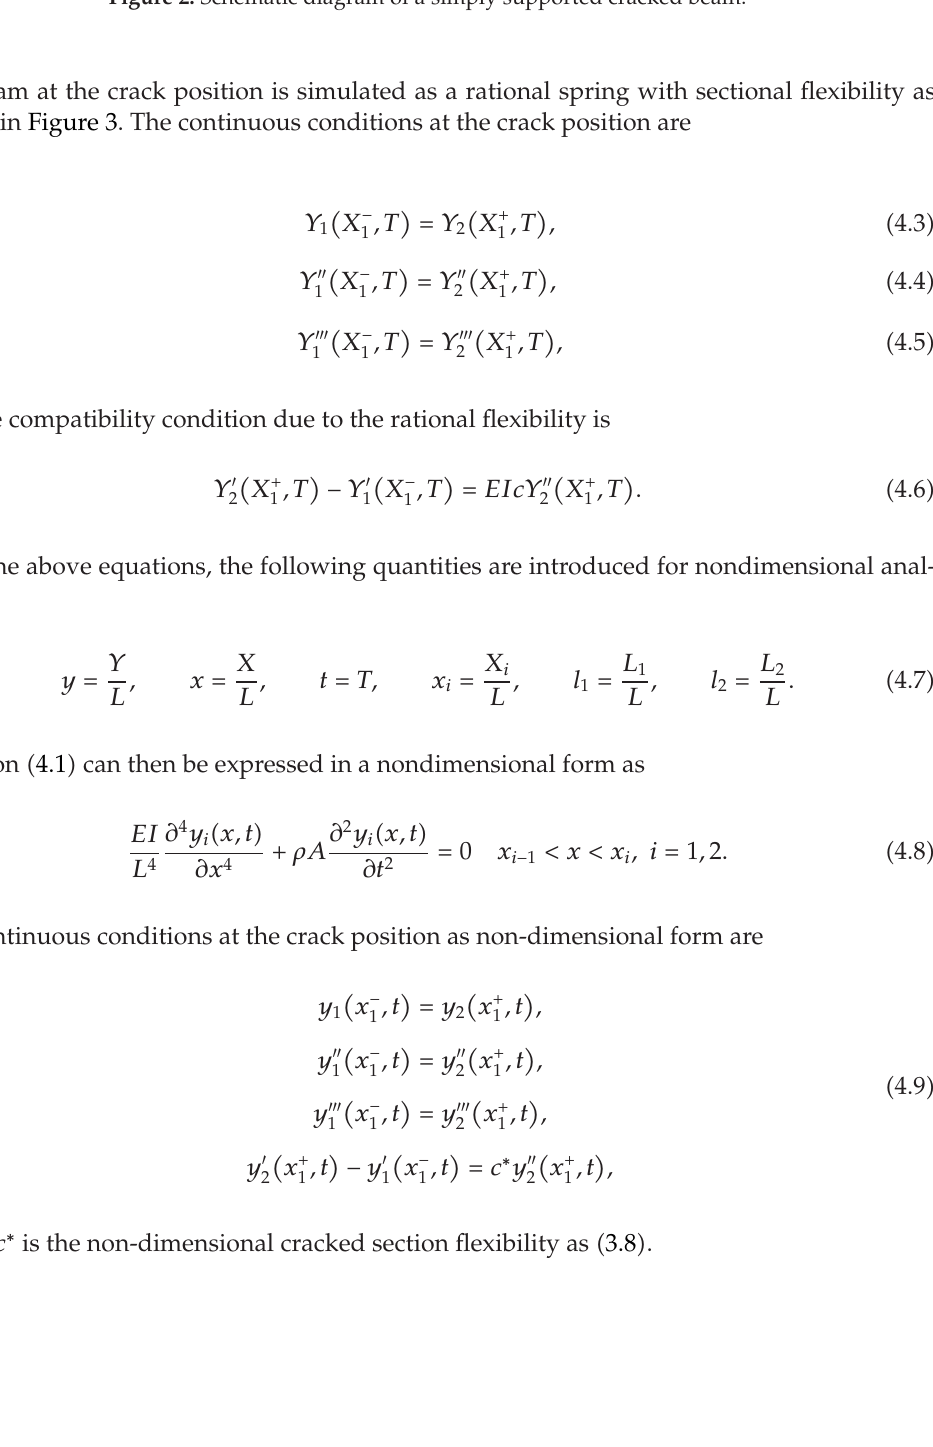
Figure 2: Schematic diagram of a simply supported cracked